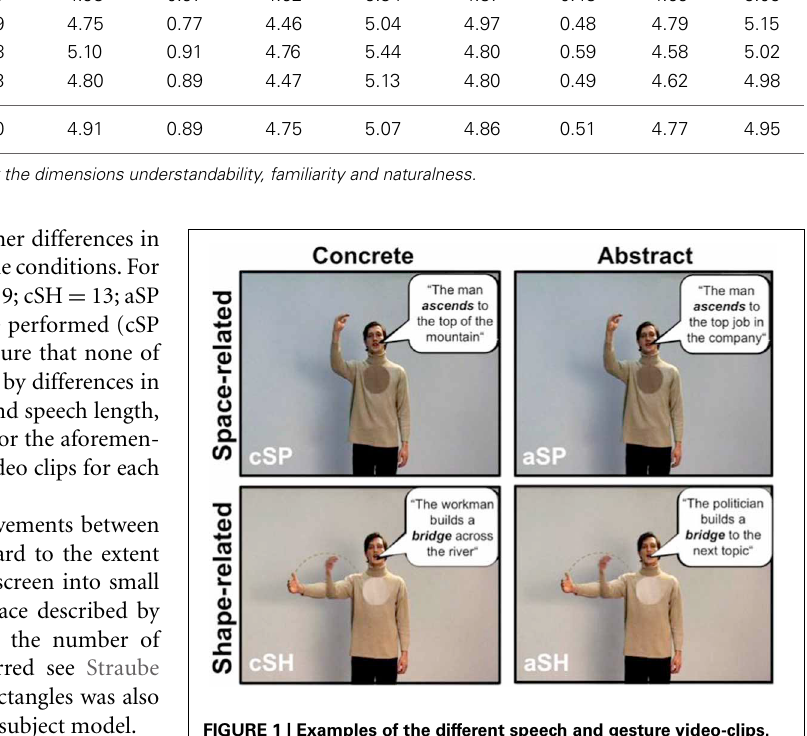
FIGURE 1 | Examples of the different speech and gesture video-clips. The stimulus material consisted of video clips of an actor performing either space-related (top) or shape-related (bottom) gestures to corresponding sentences with an concrete (left) or abstract content (right) . One screen shot of an example video is shown for each condition (cSP, concrete space-related; cSH, concrete shape-related; aSP, abstract space-related; aSH, abstract shape-related). In order to exemplify the stimulus material German sentences are translated into English, and written in speech bubbles for illustration (unlike in the actual